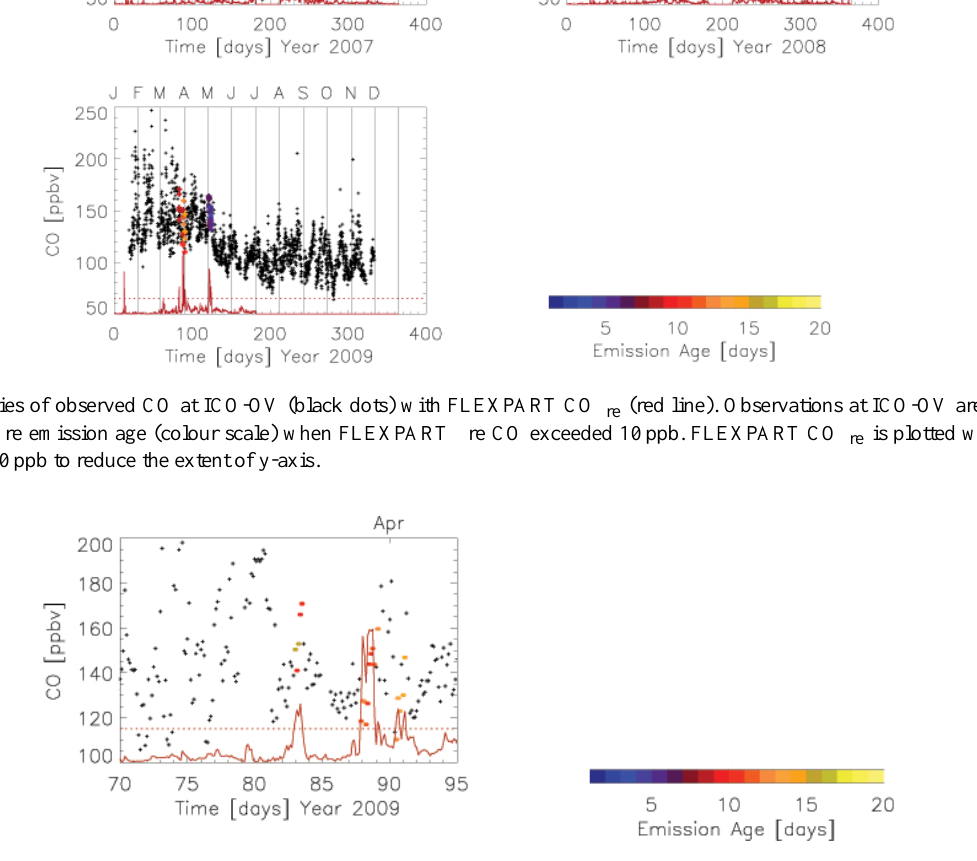
Fig. 3b. Time series of observed CO concentration at ICO-OV (black dots) with FLEXPART CO fire (red line) for 11 March–6 April 2009. Observations at ICO-OV are tagged with the FLEXPART fire emission age (colour scale). FLEXPART CO is plotted with a positive bias of 50ppb to reduce the extent of